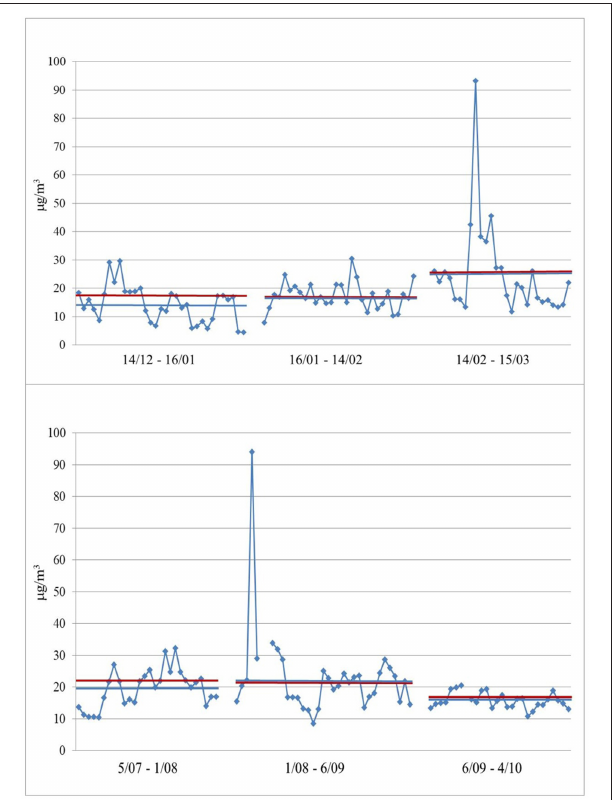
FIGURE 9 | Time pattern of PM 10 concentration measured daily by the local environmental agency at the monitoring station of Termica Milazzo (TER), in winter (upper panel) and summer (lower panel); mean values referring to the six sampling periods (blue line) and monthly mean concentration measured by this study (red